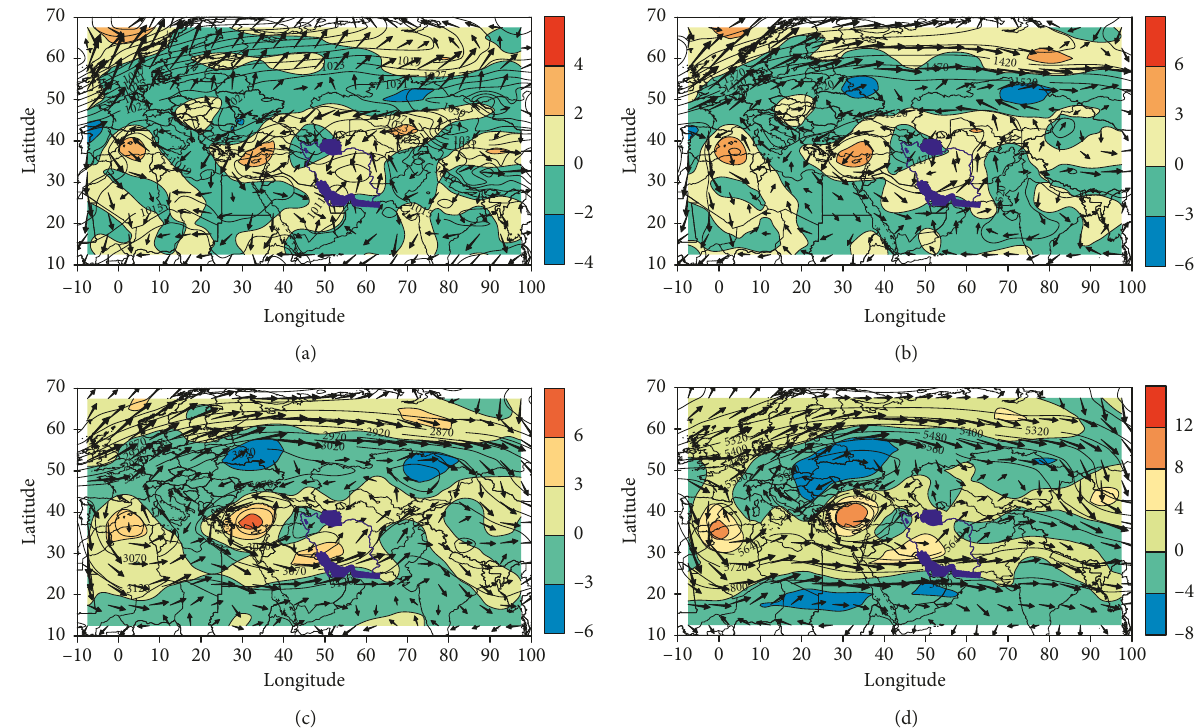
5 10 ) (shaded), and wind flow (m/s) (vectors). (b) 850hPa height, 1 S × − −